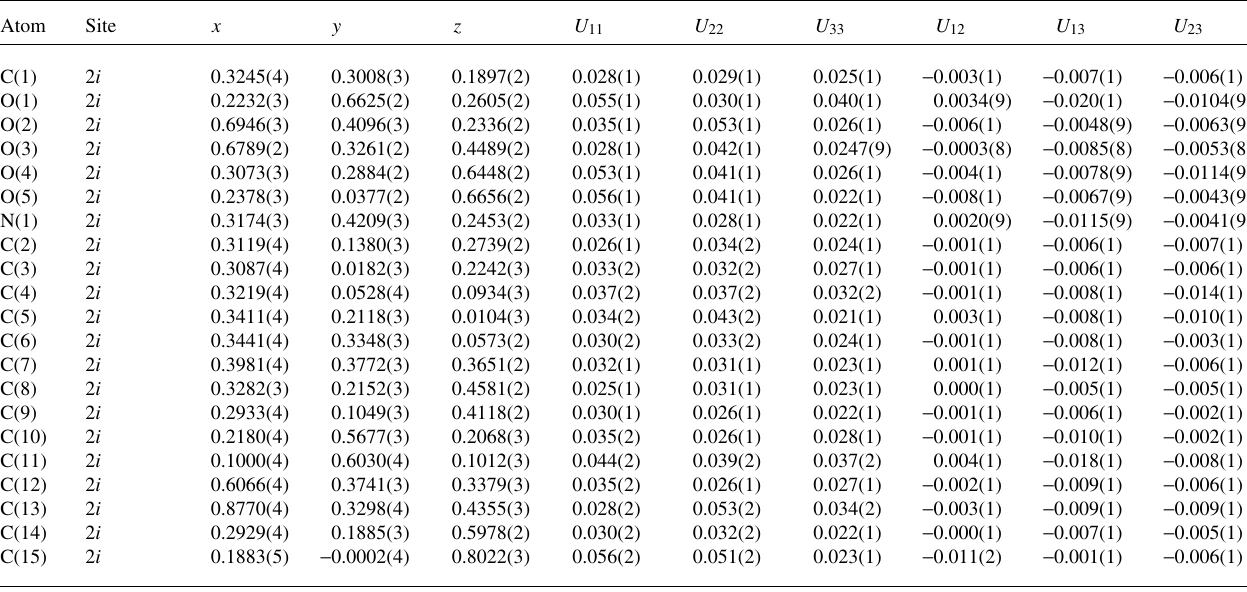
Table 3. Atomic coordinates and displacement parameters (in Å 2 )